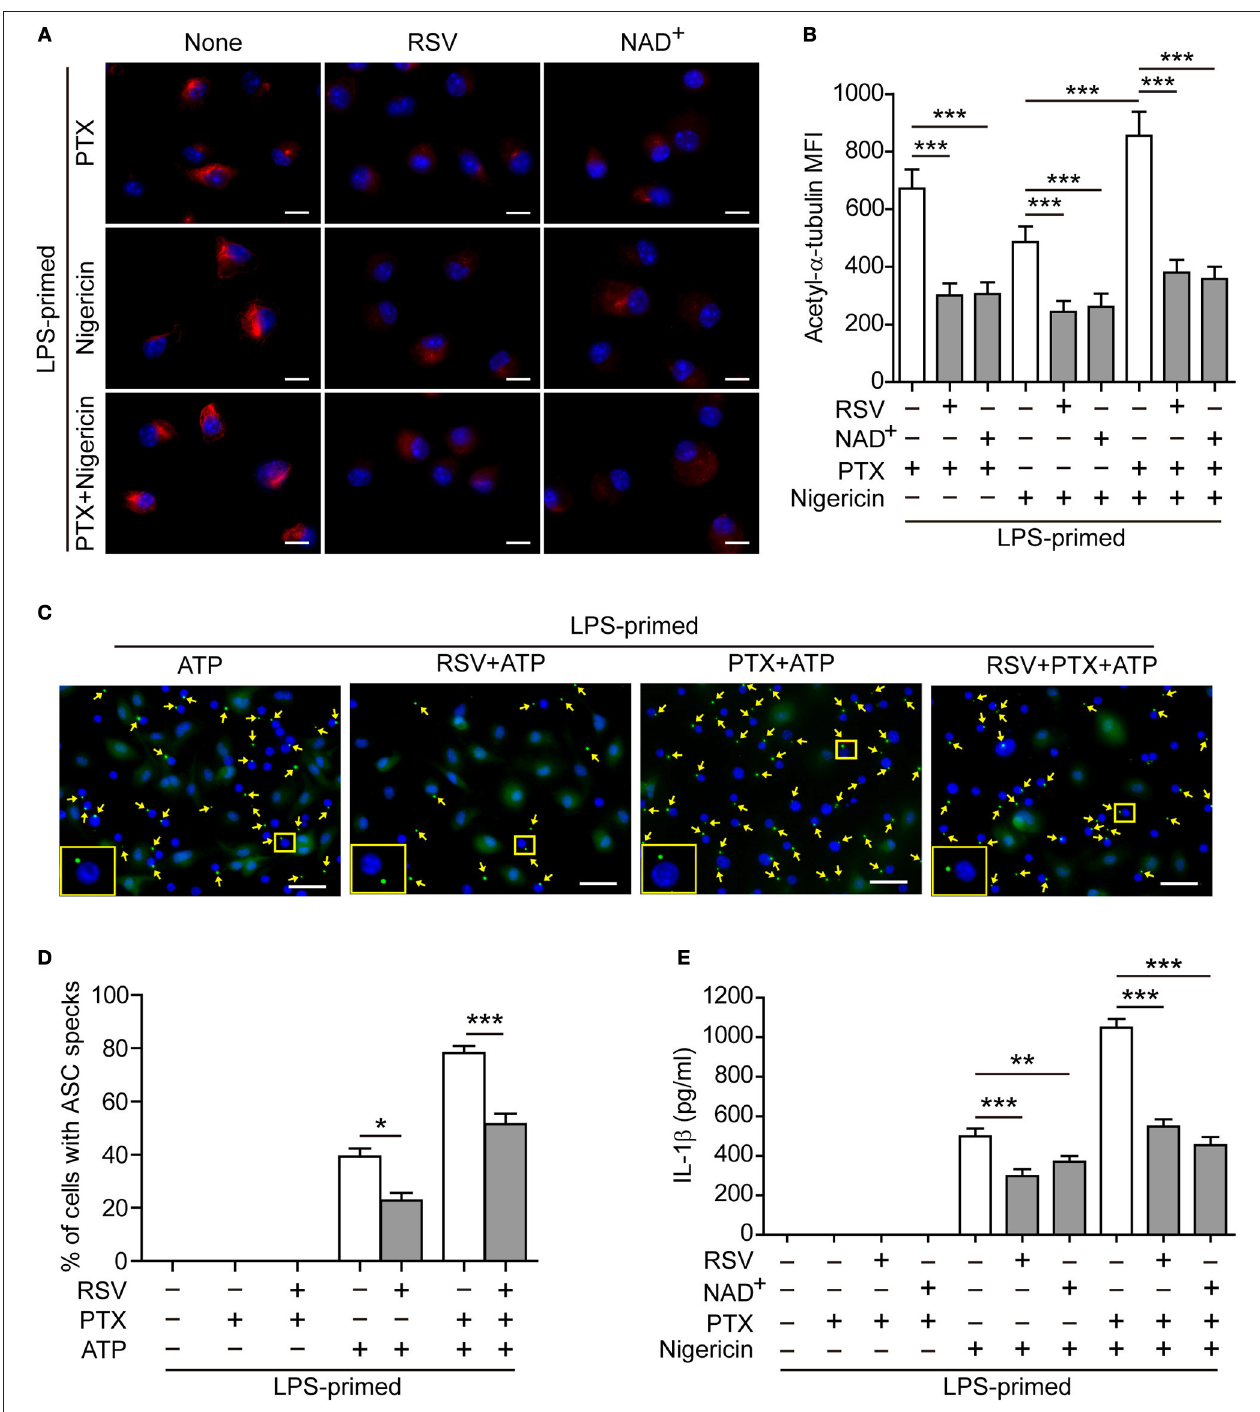
FIGURE 4 | Resveratrol and NAD + suppressed paclitaxel-mediated augmentation of NLRP3 inflammasome activation. (A,B) LPS-primed BMDMs were pre-treated without (None) or with resveratrol (5 µ M) or NAD + (10 µ M) for 30min before incubation with paclitaxel (33nM) for 1h and then stimulation with nigericin (5 µ M) for 1h. After staining with indicated antibodies, the cells were observed by fluorescence microscopy and the images were captured, respectively, and merged together. Representative immunofluorescence images showing acetylated α -tubulin (red) subcellular distribution (A) . Nuclei (blue) were revealed by Hoechst 33342. Scale bars, 10 µ m. (B) Mean of fluorescence intensity (MFI) of acetylated α -tubulin was analyzed by ZEN software. Data were analyzed using the non-parametric Friedman test, which are shown as mean ± SD ( n = 5) . (C–E) LPS-primed BMDMs were pre-treated with resveratrol (5 µ M) (C, D) or NAD + (10 µ M) (E) for 30min prior to paclitaxel (100nM) treatment for 1h, followed by incubation with ATP (2mM) for 30min. The expression and subcellular distribution of ASC were revealed by